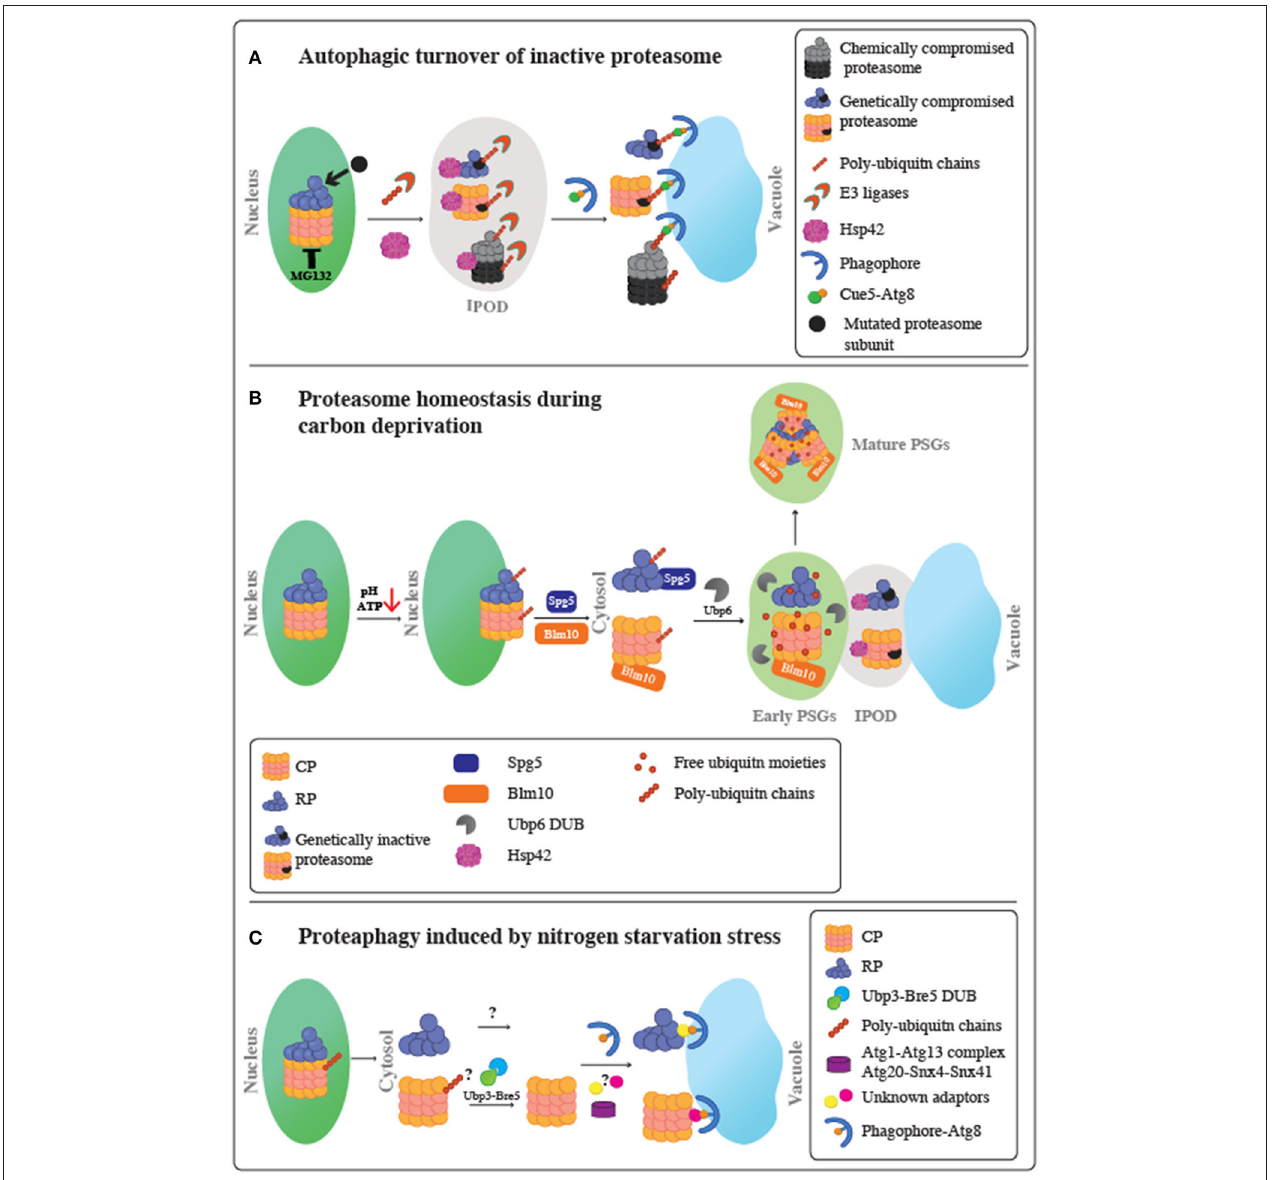
FIGURE 1 | Schematic representation of proteasome fate under various stress conditions. (A) Autophagic turnover of inactive proteasome. Following proteasome inactivation, Hsp42 mediates the accumulation of inactive subunits at the IPOD. Proteasomes also become extensively modified with poly-ubiquitin chains in a process mediated by an as yet unidentified E3 Ub ligase. Moreover, it remains unclear whether this ubiquitination step occurs before or after entry to the IPOD. Ubiquitinated proteasomes then associate with the ubiquitin receptor, Cue5, which simultaneously binds to Atg8, leading to their targeting to the autophagic membrane, and proteophagy. Chemical inactivation of proteasomes using the reversible proteasome inhibitor, MG132, stimulates autophagy of both the core particles (CP) and regulatory particles (RP) at similar rates. A genetically compromised RP subunit did not stimulate proteophagy of the CP, and the other way around. Thus, proteaphagy is not restricted to the holo-complex, and RP or CP can be degraded individually. (B) Proteasome homeostasis during carbon deprivation. Upon glucose starvation, intracellular ATP levels and pH decrease. This triggers the dissociation of the proteasome holo-complex to CP and RP subcomplexes, migration to the nuclear periphery and a stepwise export from the nucleus to the cytoplasm to form PSGs, membrane-less assemblies of soluble proteins. The first step in the CP and RP cytoplasmic delivery is mediated by Blm10 and Spg5, respectively. This step results in transient association of proteasomes with the IPOD, together with other IPOD proteins, such as Hsp42, to form inclusions termed early PSGs. While mutated inactive proteasomes are retained in these inclusions, the functional CP and RP particles are targeted to form the mature PSGs, which protects functional proteasomes from autophagy. Mature PSG assembly requires the proteasome associated protease, Ubp6, to release free ubiquitin from branched ubiquitin chains on nuclear proteasomes, resulting in a compact granule containing RP, Blm10-CP, and free ubiquitin moieties. This process is reversible; when glucose again becomes available, PSGs disperse, allowing cells to quickly re-enter the cell cycle without waiting for new de novo proteasome assembly. (C) Proteaphagy induced by nitrogen starvation stress. Upon nitrogen starvation, similarly to carbon depletion, proteasomes are exported from the nucleus to the cytoplasm most likely when the holo-complex is dissociated to CP and RP complexes. Then, each RP and CP is separately